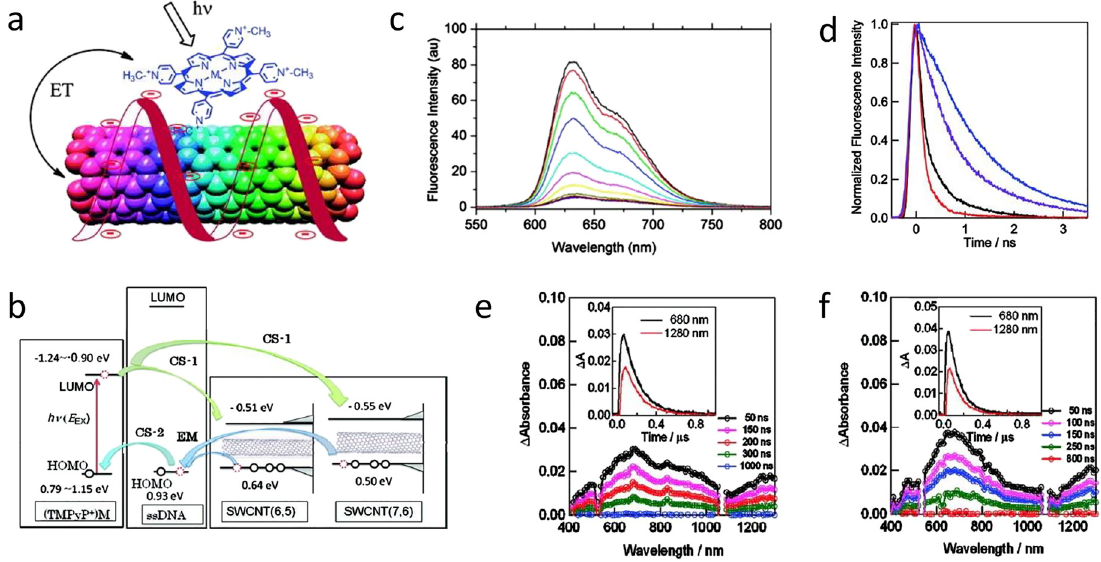
Figure 2: (a) Schematic description of the (TMPyP + )M/ssDNA/SWCNT bionanohybrids, (M = Zn or H 2 ), (b) scheme of the energy-level diagram forthephotoinducedelectrontransferprocesses,(c)steady-state fl uorescencespectralchangesof(TMPyP + )Zn(10 μ M)onadditionofssDNA/ SWCNT(7, 6) in H 2 O ( λ ex = 435 nm), (d) fl uorescence decays of (TMPyP + )Zn in H 2 O ( λ ex = 408 nm). Lines from right to left are (TMPyP + )Zn, addition of ssDNA, addition of ssDNA/SWCNT(6, 5) and addition of ssDNA/SWCNT(7, 6), (e, f) ns-TA of (TMPyP + )Zn/ssDNA/SWCNT( n , m ) observed by 532 nm laser light irradiation in H 2 O, (e) SWCNT(6, 5) and (f) SWCNT(7, 6) [27]. ns-TA, nanosecond transient absorption; SWCNT, single-wall carbon